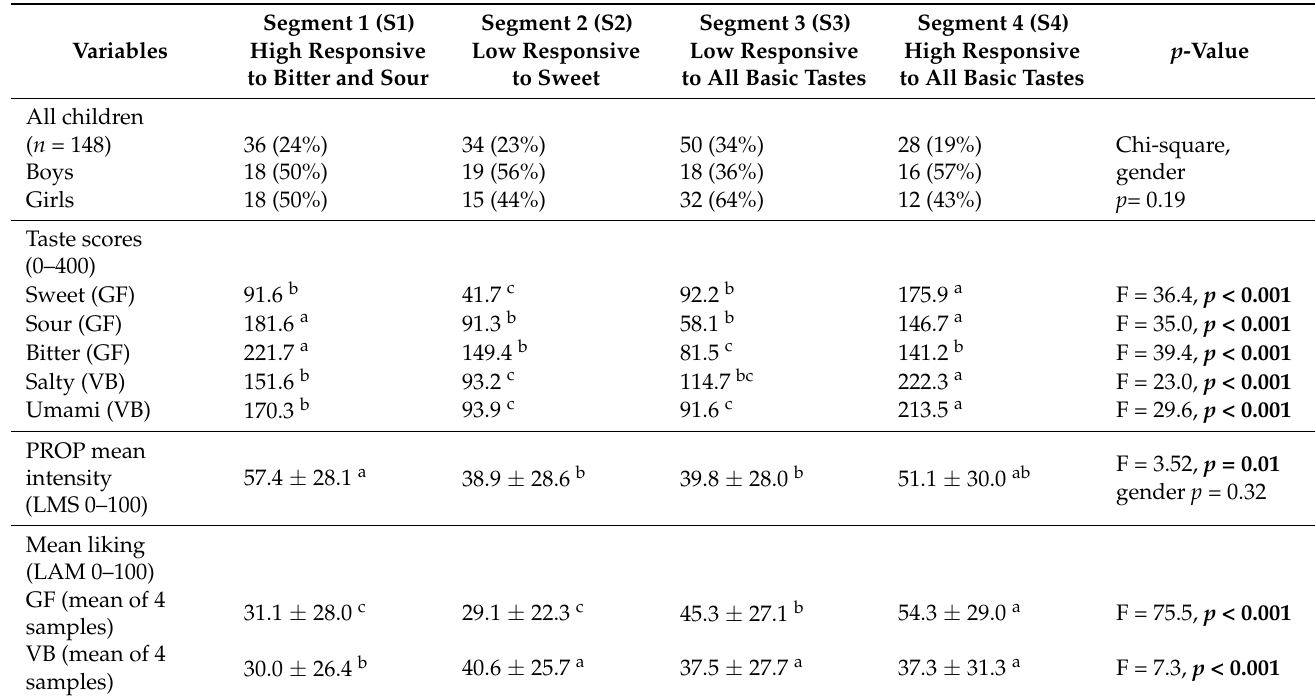
Table 2. Segment profiles according to taste score, perceived intensity, PROP intensity, and mean liking for model